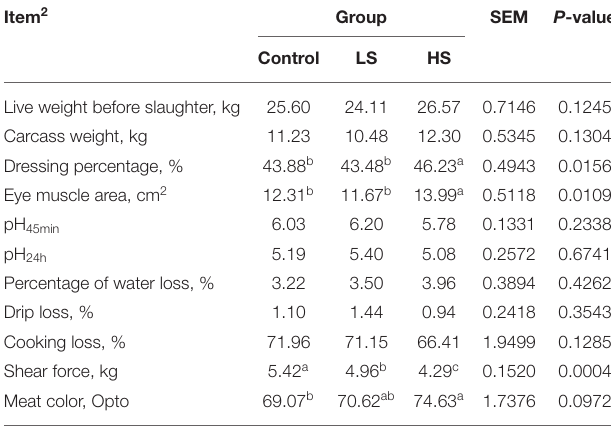
TABLE 3 | Effect of selenium-yeast on muscle antioxidant activity and immune of goats 1 .